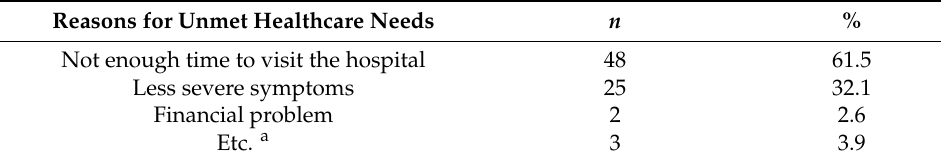
Table 3. Reasons for adolescents’ unmet healthcare needs ( n =